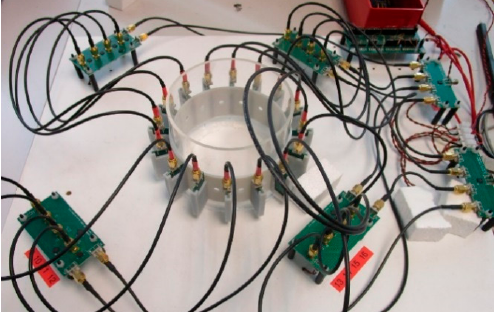
Figure 5. Photograph of the experimental set up.